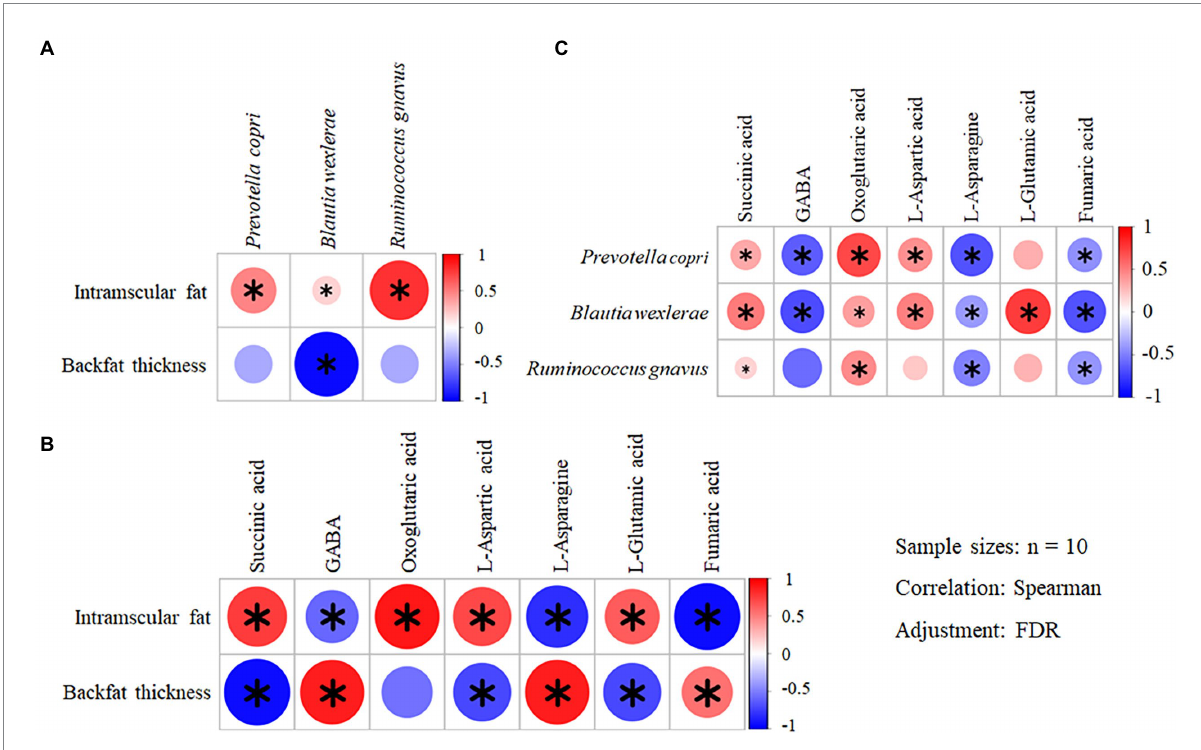
FIGURE 10 Correlation analyses of the differential MQT-LM – species – metabolites in Xinjiang brown cattle (BC) and Angus cattle (AG). ( n = 10). Correlation of the differential MQT-LM and species (A) ; Correlation of the differential MQT-LM and metabolites (B) ; Correlation of the differential species and metabolites (C) . * denotes p < 0.05 indicating significant